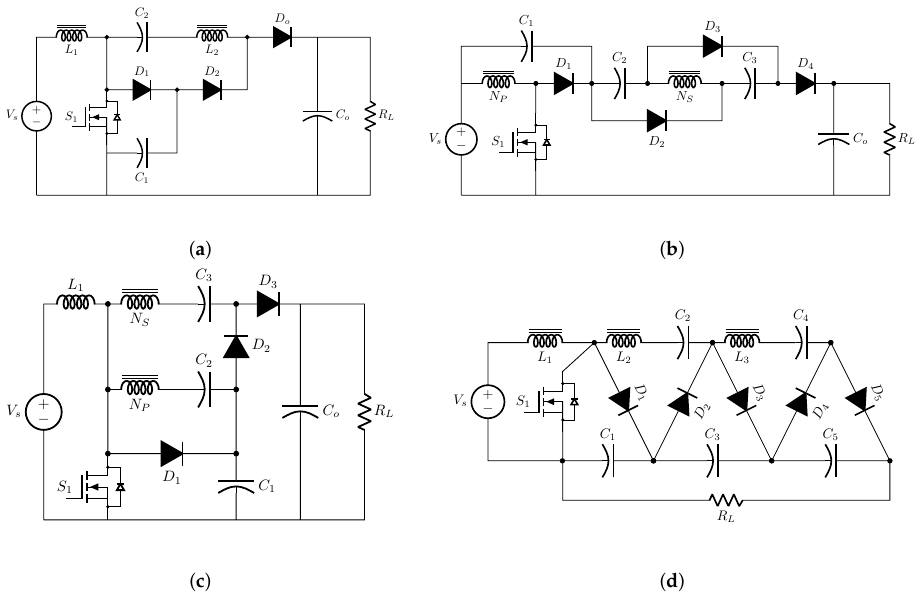
Figure 18. Coupled Inductor Techniques. ( a ) Boost Converter based on Coupled Inductor, ( b ) Boost Converter based on Two Capacitors and Coupled Inductor, ( c ) Boost Converter based on a Coupled Inductor and ( d ) Boost Converter with 3-winding Coupled Inductor.